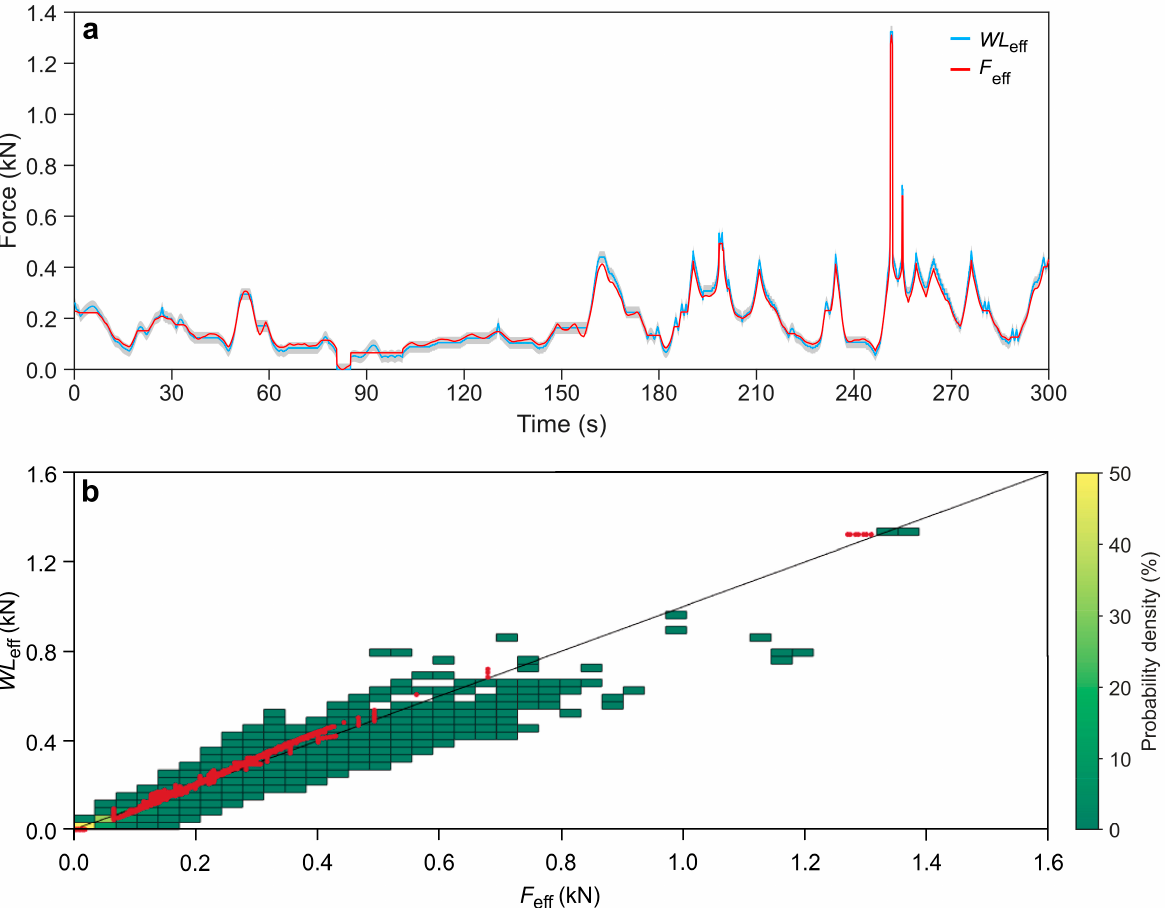
Figure 8. ( a ) Time series (300 s) of instantaneous WL eff and F eff of sample tree B4. The grey region shows the standard deviation of the residuals from WLP values of the second phase (i.e., for all values greater than detected change points) of the two-phase linear regression model. ( b ) WL eff plotted against F eff (red dots) and bivariate histogram bins (green tiles) that represent the total wind-induced response of B4 in the study period. 84% of the displayed values are smaller than WL eff < 0.1 kN (yellow and light green bins), indicating the dominance of episodes with low wind loading in the study period.